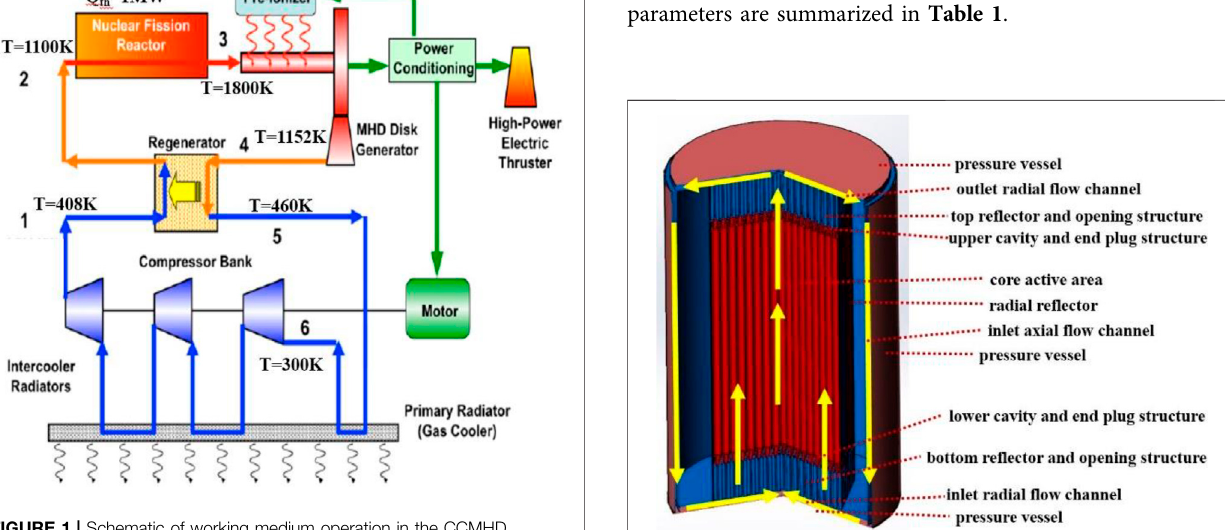
FIGURE 3 | Schematic of the coolant fl ow path.